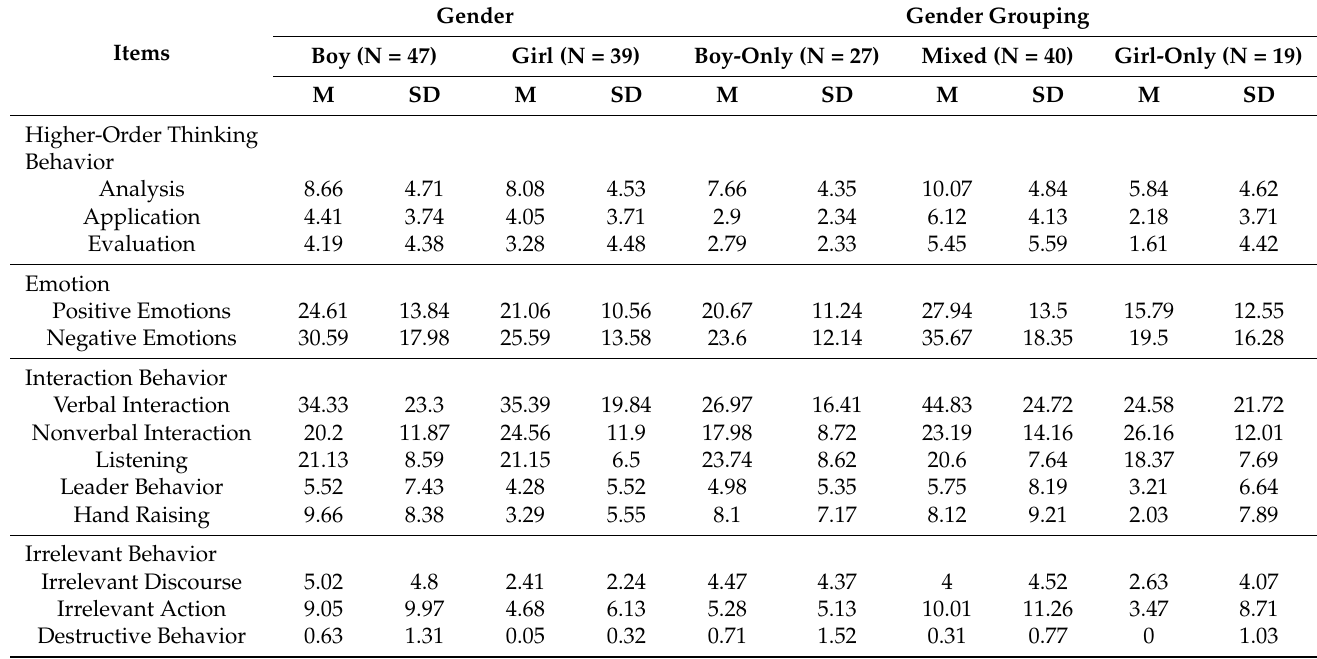
Table A1. Means and standard deviations for genders and gender groupings.